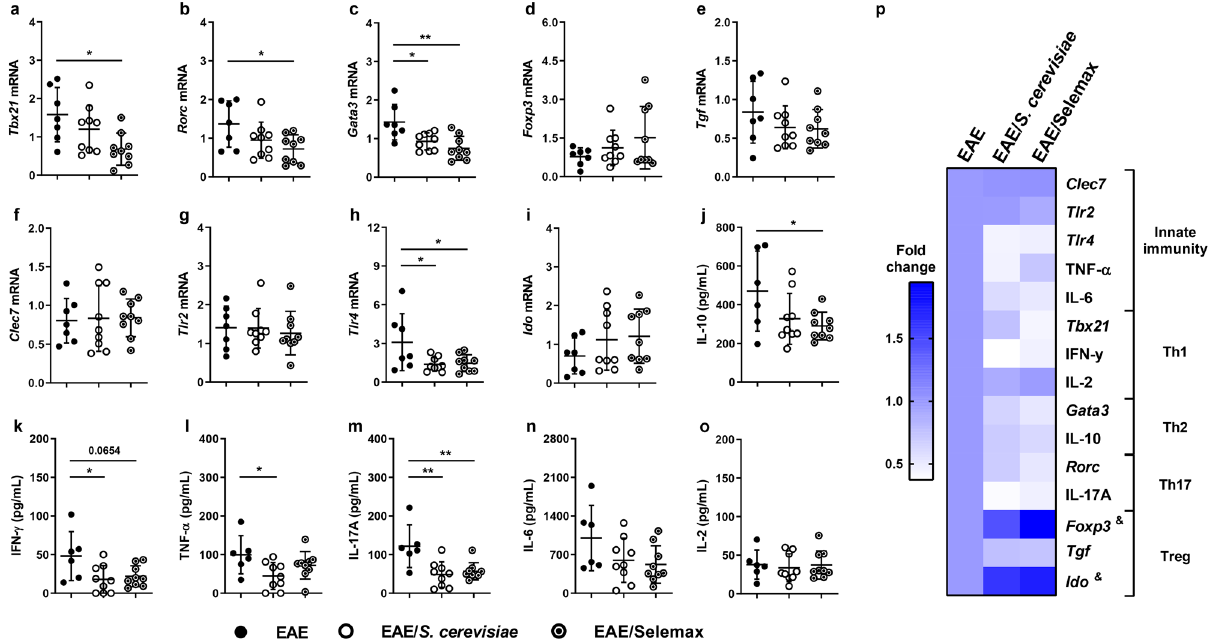
Figure 8. Effect of S. cerevisiae and Selemax on intestinal mucosal inflammatory markers. EAE mice received 14 oral doses of S. cerevisiae or Selemax. The mRNA expression of Tbx21 ( a ), Rorc ( b ), Gata3 ( c ), Foxp3 ( d ), Tgf ( e ), Clec7 ( f ), Tlr2 ( g ), Tlr4 ( h ) and Ido ( i ) were performed in small intestine samples. Gut explants of small intestine were cultured for 6 h and the production of IL-10 ( j ), IFN-γ ( k ), TNF-α ( l ), IL-17A ( m ), IL-6 ( n ) and IL-2 ( o ) were assessed in the supernatants. The gene expression and cytokine levels were used to calculate the fold change in relation to EAE group ( p ). Statistical analysis was performed by one-way ANOVA and subsequent Tukey’s test ( a – o ) and two-way ANOVA and subsequent Tukey’s test ( p ). All data were expressed as the mean ± SD and statistical differences were represented by * p < 0.05 and ** p < 0.01; & p < 0.05 between EAE and EAE/Selemax. Two independent experiments were combined, n = 7–8 mice/group. The graphs were created using GraphPad Prism v.8.0.2 and image was modified with Adobe Photoshop